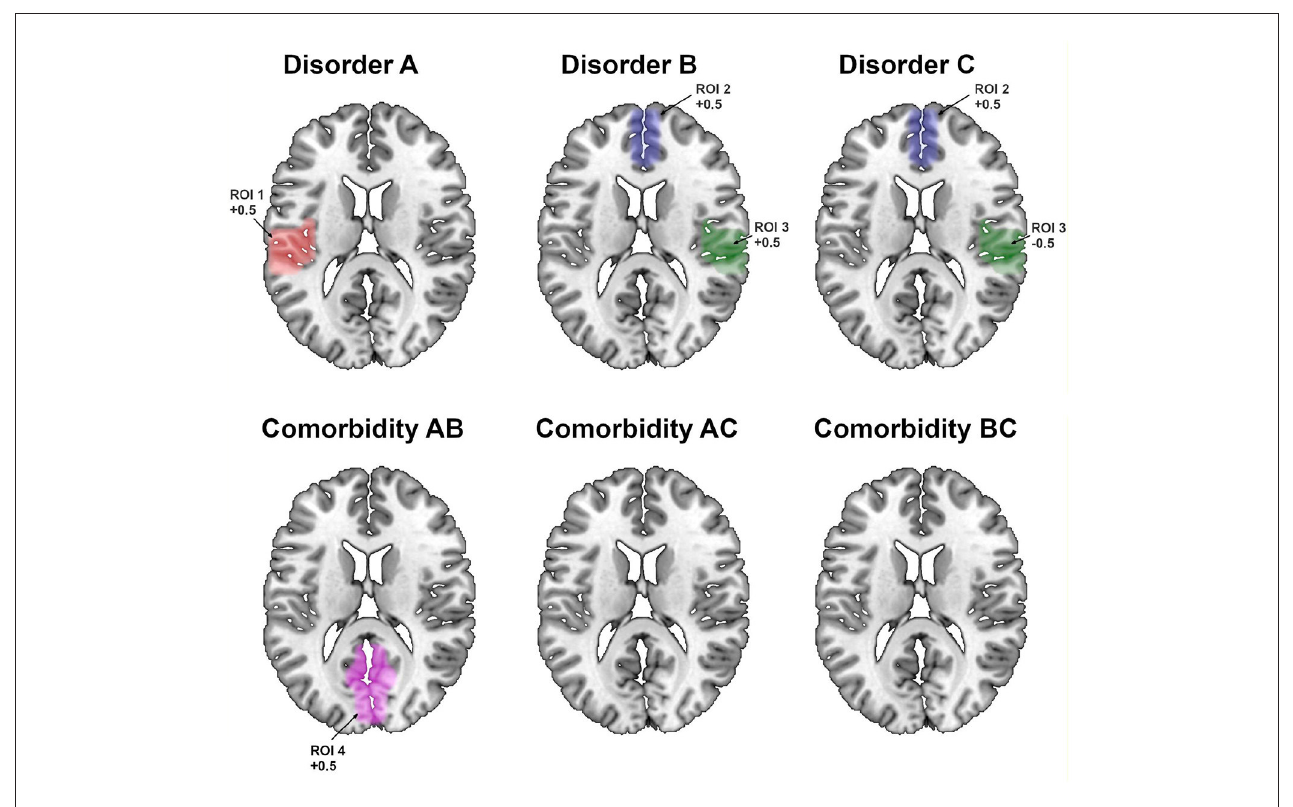
FIGURE 2 | Regions showing statistically significant effects using the novel SDM-PSI approach. ROI, region of interest.